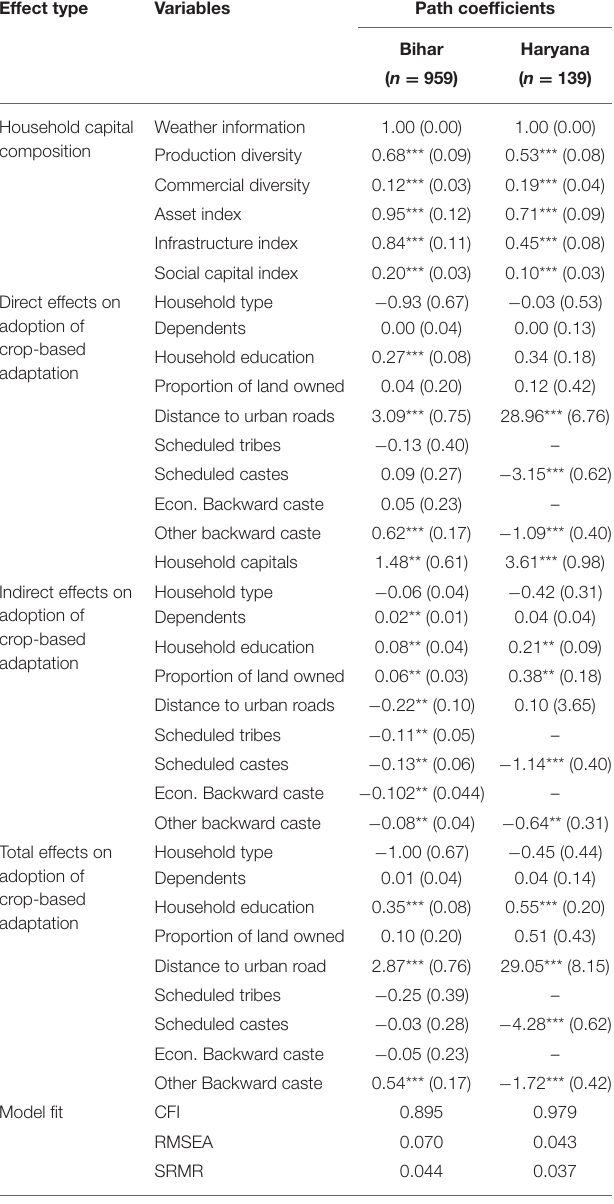
TABLE 6 | SEM results for crop-based adaptation strategies in Bihar and